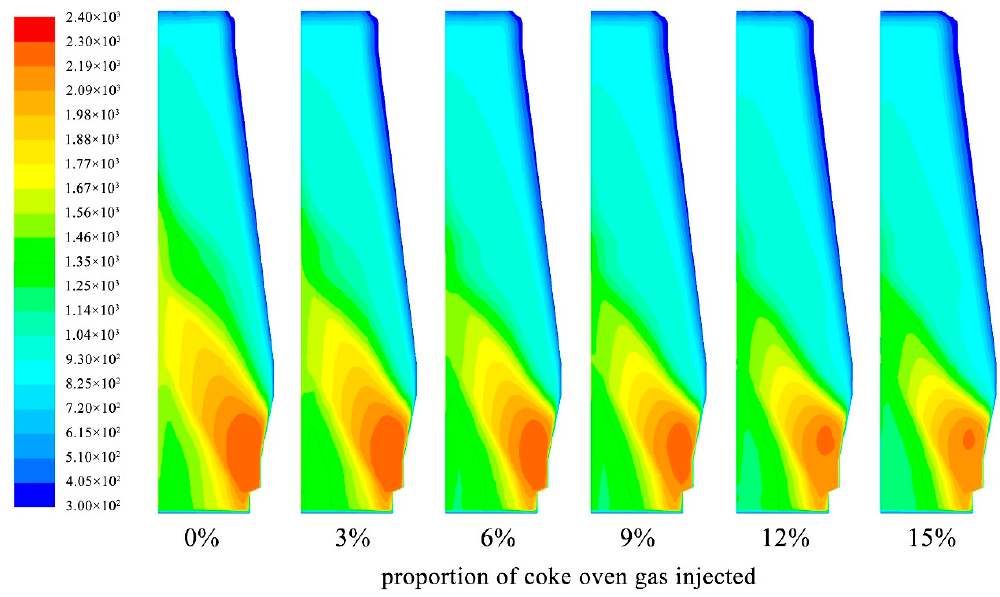
Figure 6. Temperature profiles at different proportions of coke oven gas injected.